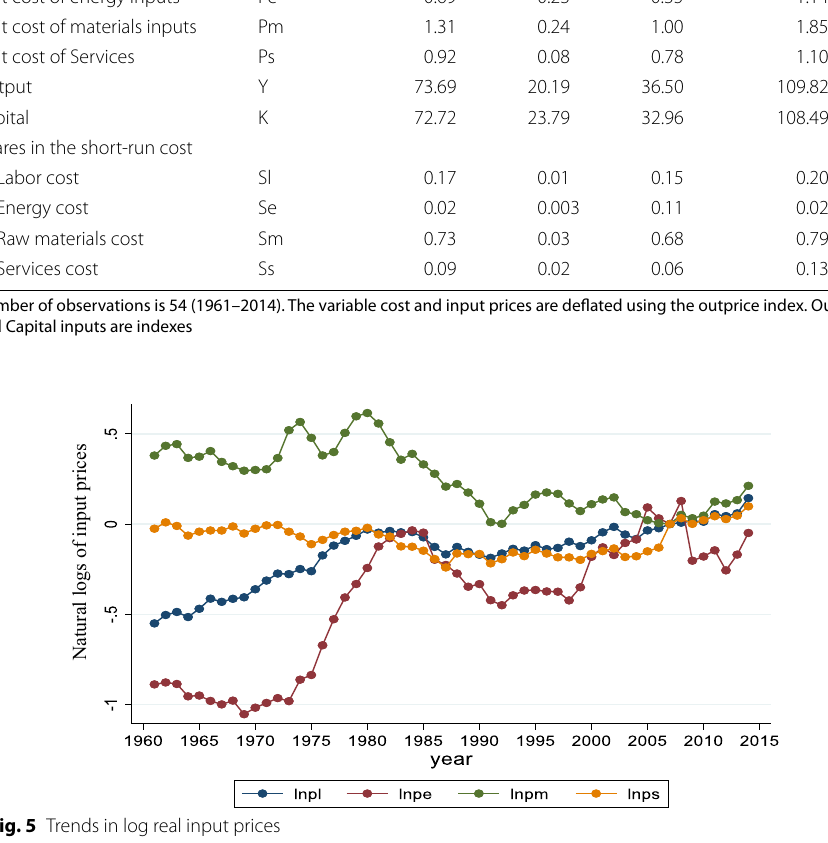
Fig. 5 Trends in log real input